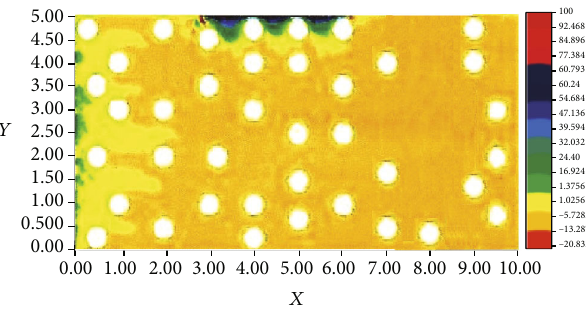
Figure 19: Concentrations, D = 0 : 0005 , C